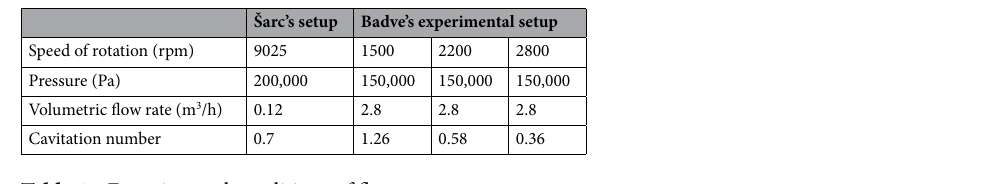
Table 1. Experimental conditions of